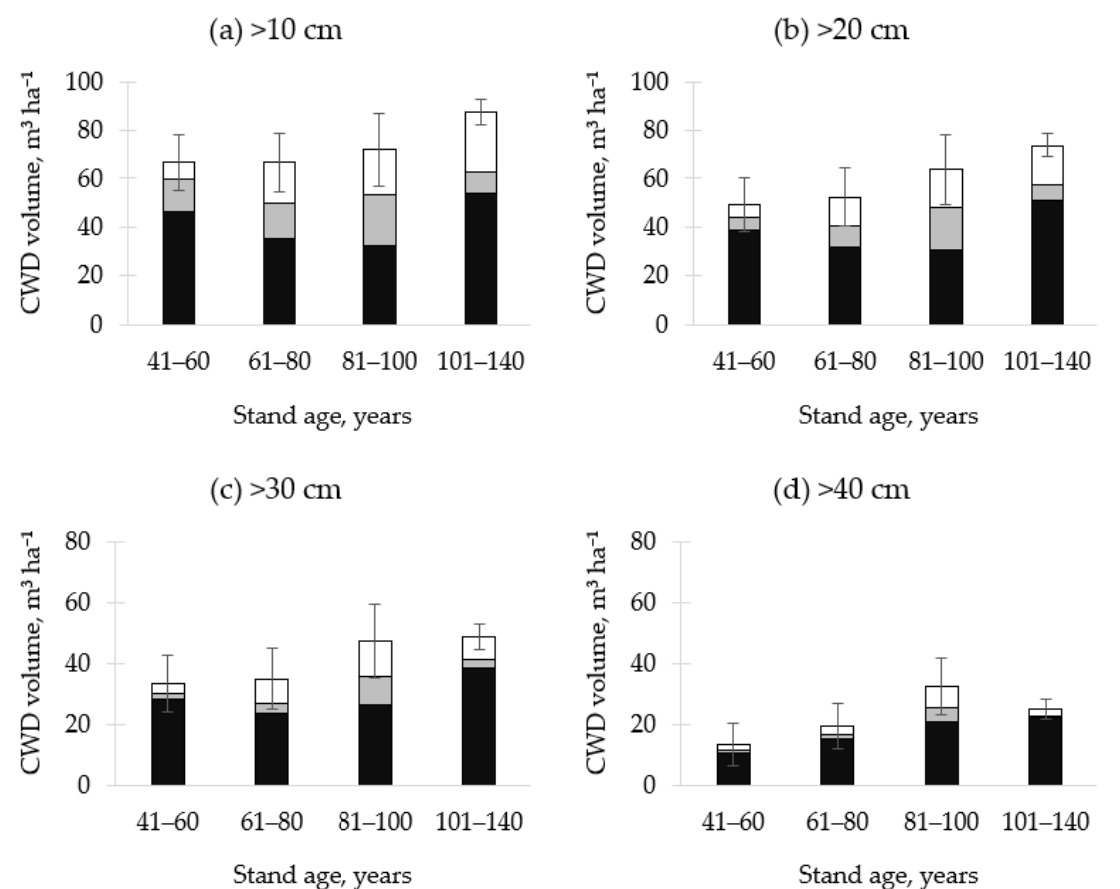
Figure 4. The marginal mean volume ( ± standard error of total volume) of aspen (black stacked bars), other deciduous (gray stacked bars) and coniferous (clear stacked bars) coarse woody debris (CWD) in mature (41–60 years; n = 30), moderately overmature (61–80 years; n= 26), overmature (81–100 years; n = 17), and old-growth (101–140 years; n = 150) unmanaged European aspen ( Populus tremula L.) stands by groups of CWD diameter: ( a ) >10 cm, ( b ) >20 cm, ( c ) >30 cm, and ( d ) >40 cm.